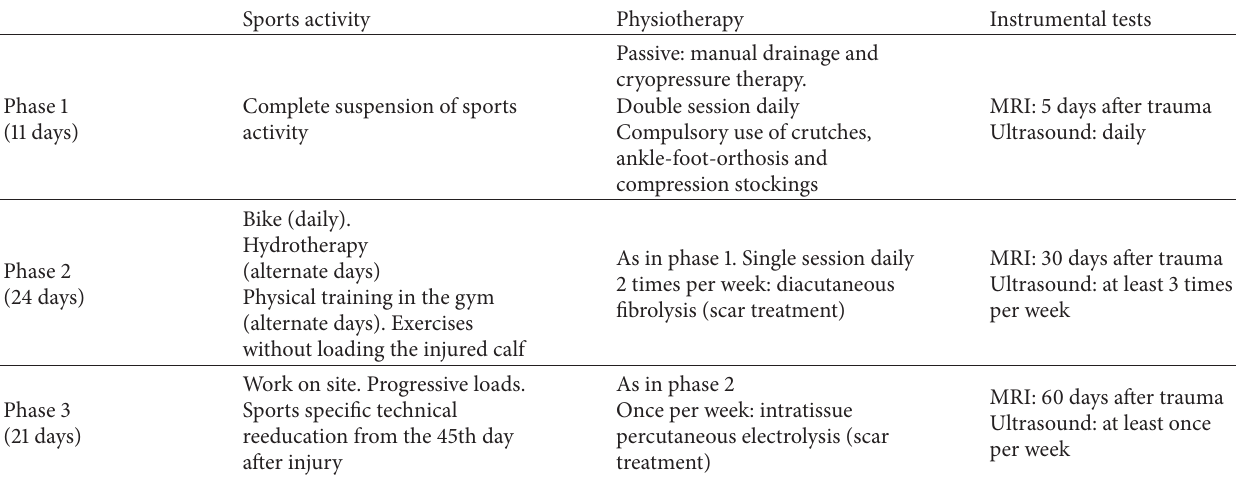
Table 1: Rehabilitation course for the recovery of the calf muscle injury.